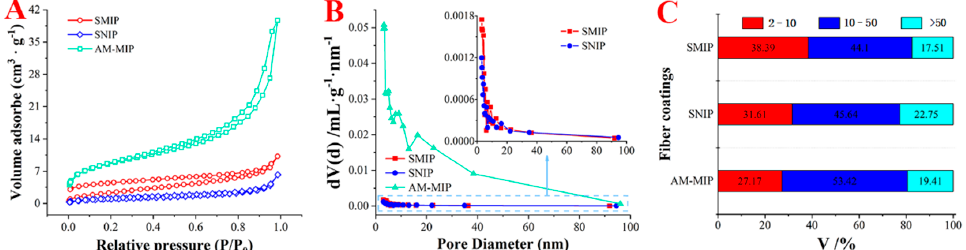
Figure 2. BET Characterization for three fiber coatings. ( A ) N 2 adsorption–desorption isotherms curve; ( B ) Pore size distribution profiles; ( C ) Different pore size ratio analysis.